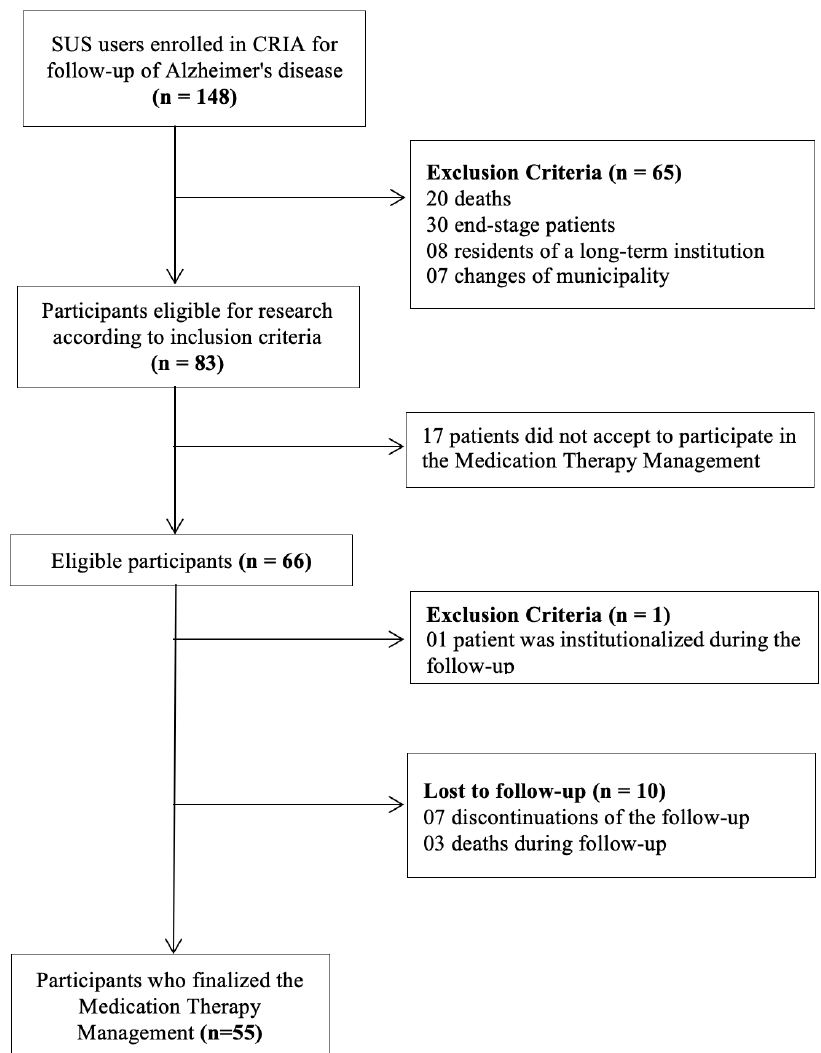
FIGURE 1 - Flowchart of patient selection for the Medication Therapy